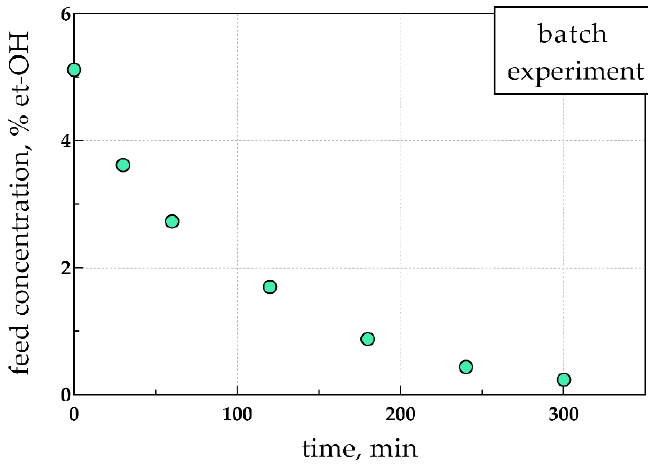
Figure 8. Time variation of ethanol concentration in the main feed tank for the batch operation.